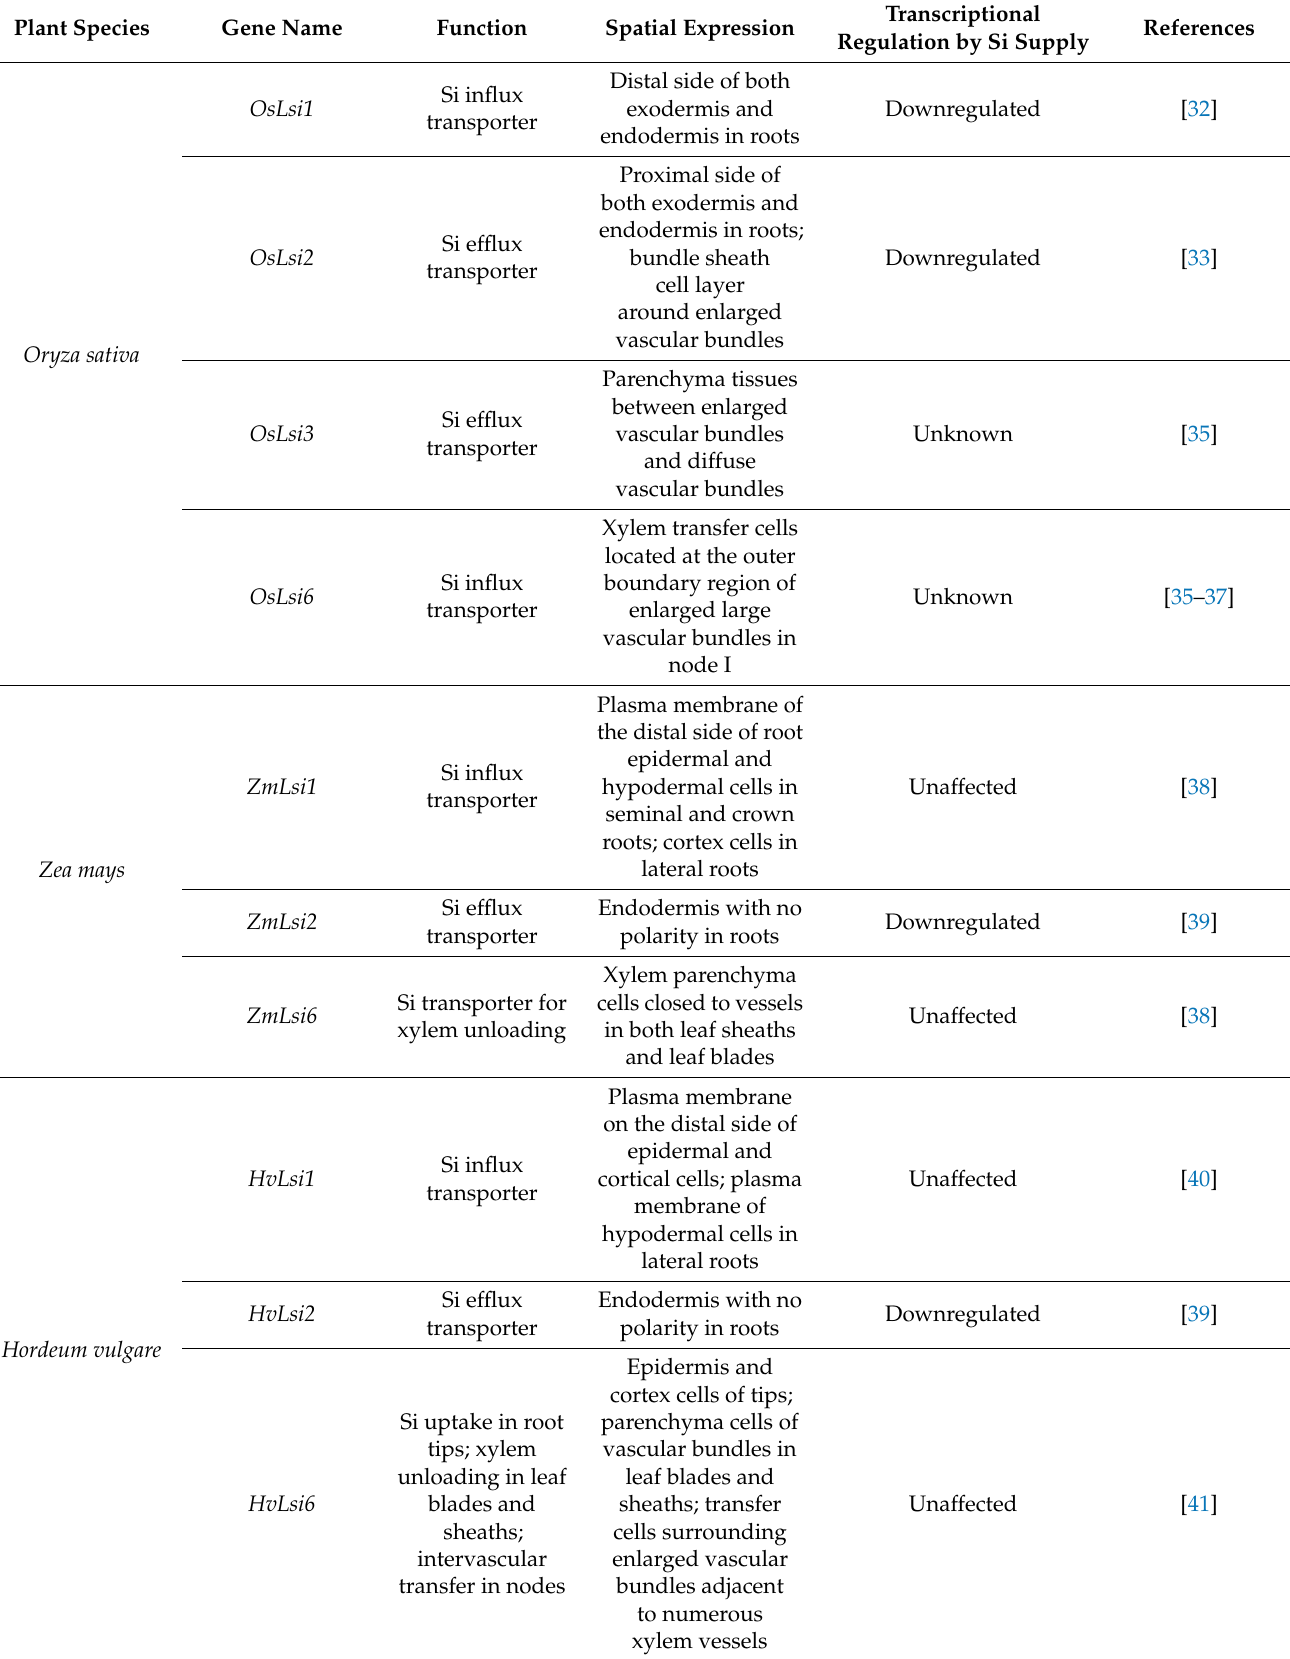
Table 1. Genes involved in Si transport in